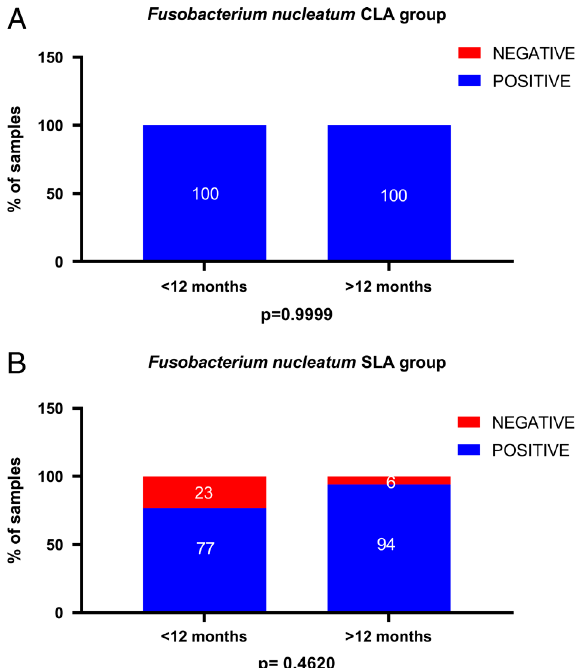
Figure 9. F. nucleatum is present in 100% of CLA samples before and after 12 months of treatment and is higher in the SLA group after 12